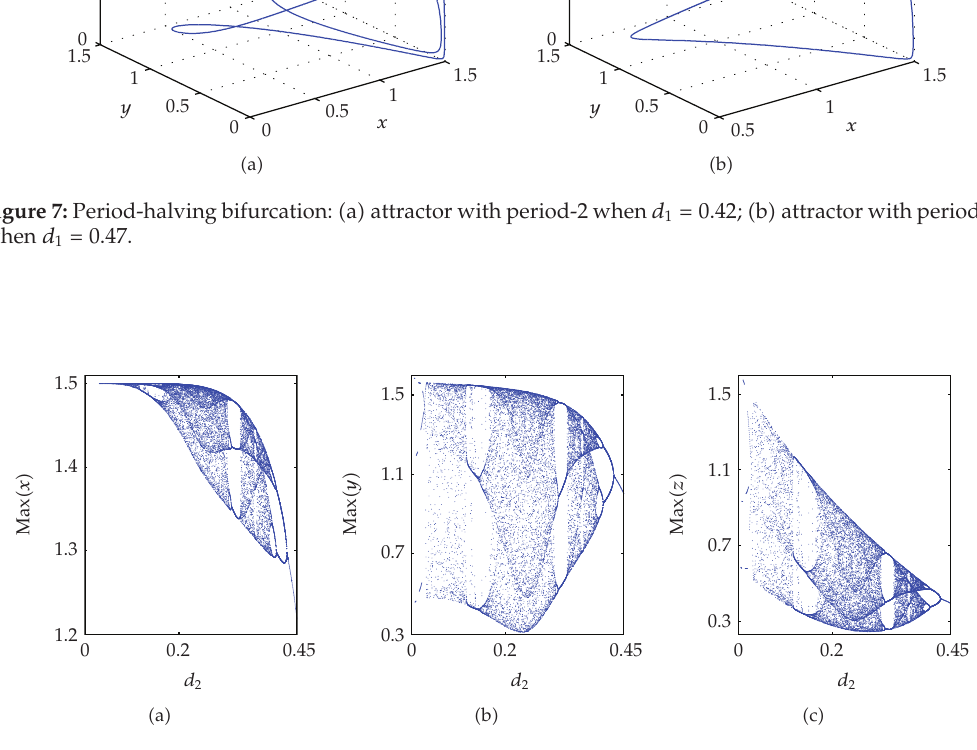
Figure 8: Bifurcation diagrams of system (cid:3) 1.2 (cid:6) with respect to d 2 : (cid:3) a (cid:6) maxima for the prey; (cid:3) b (cid:6) maxima for the mid-predator; (cid:3) c (cid:6) maxima for the top